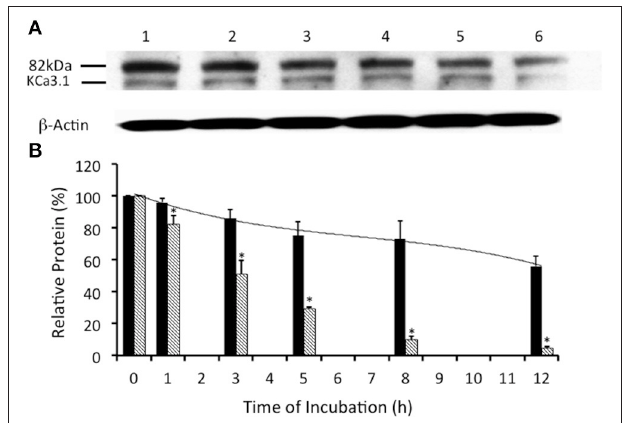
FIGURE 3 | Effects of E1-ubiquitin activating enzyme inhibition via UBEI-41 on the expression of streptavidin labeled KCa3.1-BLAP channels. (A) After basolateral streptavidin labeling of KCa3.1 channels, cells were further incubated in 37 ◦ C for 0 (no incubation), 1, 3, 5, 8, or 12 h with UBEI-41 (50 µ M) before being lysed and detection of KCa3.1 by immunoblot. Lane 1: Control no incubation ( t = 0), Lane 2: 1 h of incubation ( t = 1), Lane 3: 3 h of incubation ( t = 3), Lane 4: 5 h of incubation ( t = 5), Lane 5: 8 h of incubation ( t = 8), and Lane 6: 12 h of incubation ( t = 12). Each lane was loaded with 30 µ g of protein and β -actin was used as a loading control. (B) Relative expression levels of KCa3.1 in the presence of UBEI-41 (black bars). Relative expression levels of KCa3.1 (serving as control data) from Figure 2 were plotted (hatched bars). Relative protein expression demonstrated that the expression level of KCa3.1 (control, 0 h, black bar) remained the same after 1 h of treatment of UBE-41, but was higher than the 1 h control non-treated cells (hatched bars). Also, by 3 h only ∼ 10% of the labeled channel had been degraded compared with the 0 h control, however, at 3 h, the non-treated cells exhibited degradation of ∼ 50% of the labeled KCa3.1 (hatched bar) (* P ≤ 0.05, n = 4). Thus, UBEI-41 effectively slowed the degradation of KCa3.l, extending the channel half-life to more than 12 h compared to non-treated control cells ( ∼ 3 h).